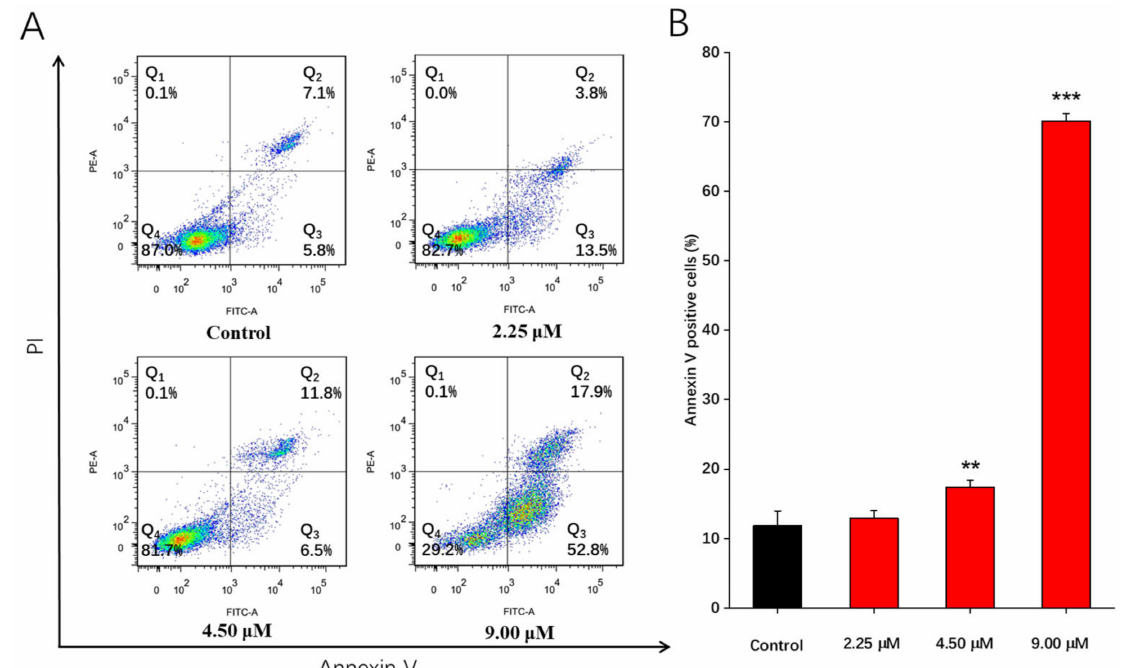
Figure 1. Compound 1b -induced apoptosis on A549 cells. A549 cells were treated with 2.25,